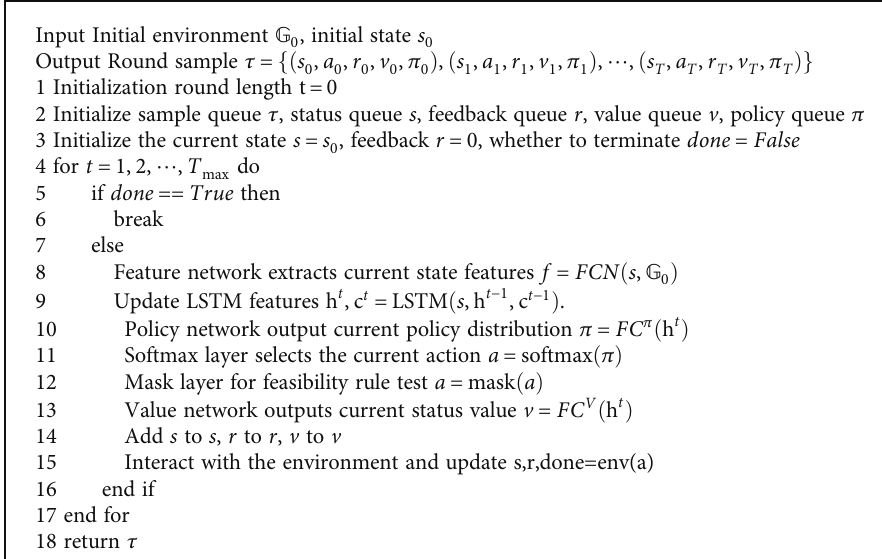
Algorithm 1: Urban parcel road generation algorithm. Road generation algorithm of urban land.